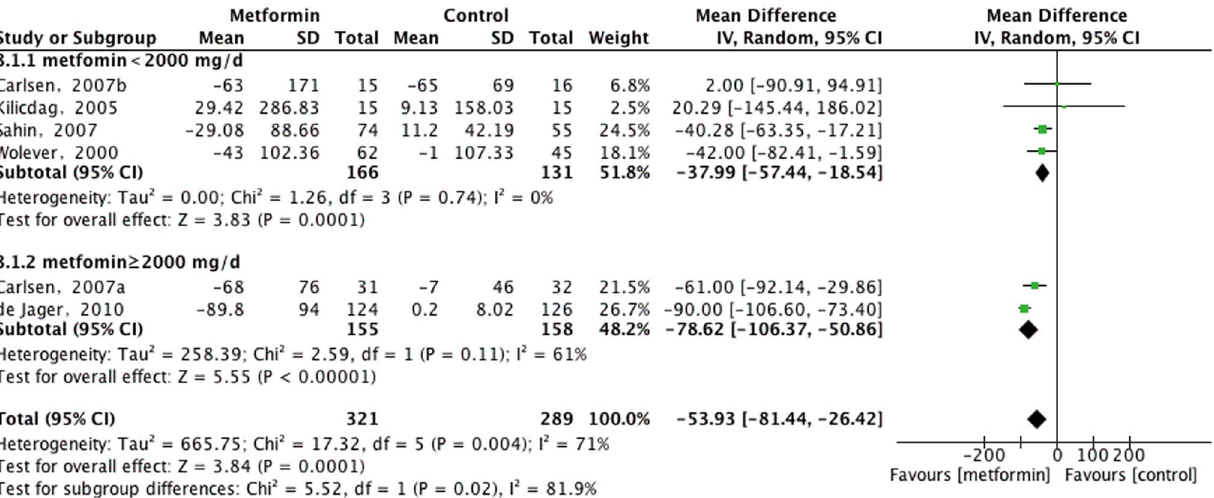
Figure 2. Effects of metformin on compared with other interventions vitamin B 12 concentration.